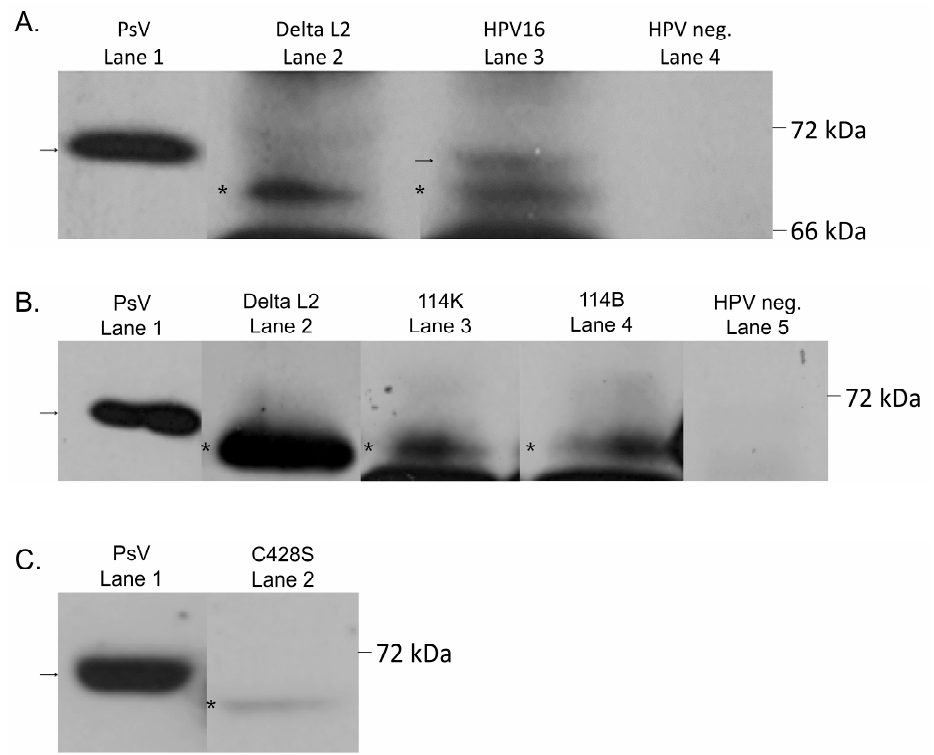
Figure 5. Cleavage of the L2 capsid protein from native virus. ( A ) Western blot analysis of HPV16 L2. Lane 1: HPV16 PsV, lane 2: HPV16 L2 expression plasmid with N-terminal deletion, lane 3: HPV16 114B NV, lane 4: HPV-negative primary raft lysate; ( B ) Western blot analysis of HPV16 L2 from two European isolates. Lane 1: HPV16 PsV, lane2: HPV16 L2 expression plasmid with N-terminal deletion, lane 3: HPV16 114K NV, lane 4: HPV16 114B NV, lane 5: HPV-negative primary raft lysate; ( C ) Western blot analysis of an HPV16 L1 mutant virus. Lane 1: HPV16 PsV, lane 2: HPV16 C428S NV. The